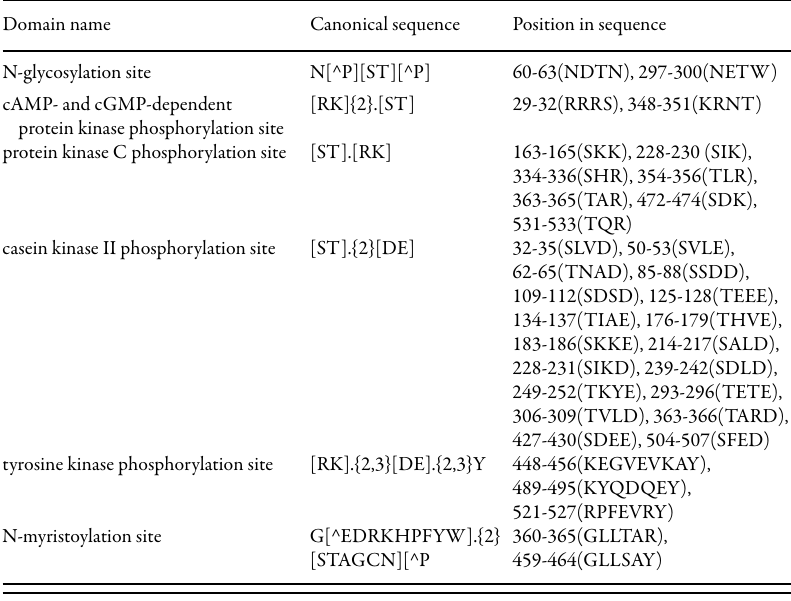
table 2. Predicted function motifs in the PvtH protein of Polyrhachis vicina.